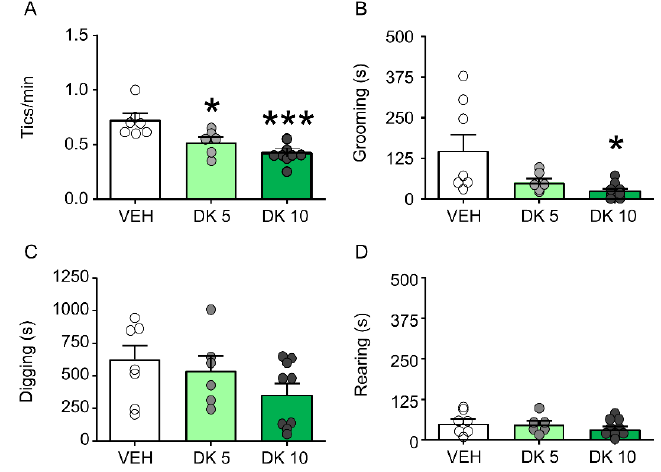
Figure 3. Effects of DK-I-56-1 (DK) on Tourette Syndrome-related motoric responses in D1CT-7 mice exposed to spatial confinement. DK significantly reduced ( A ) tic-like responses (F(2,15) = 9.66,